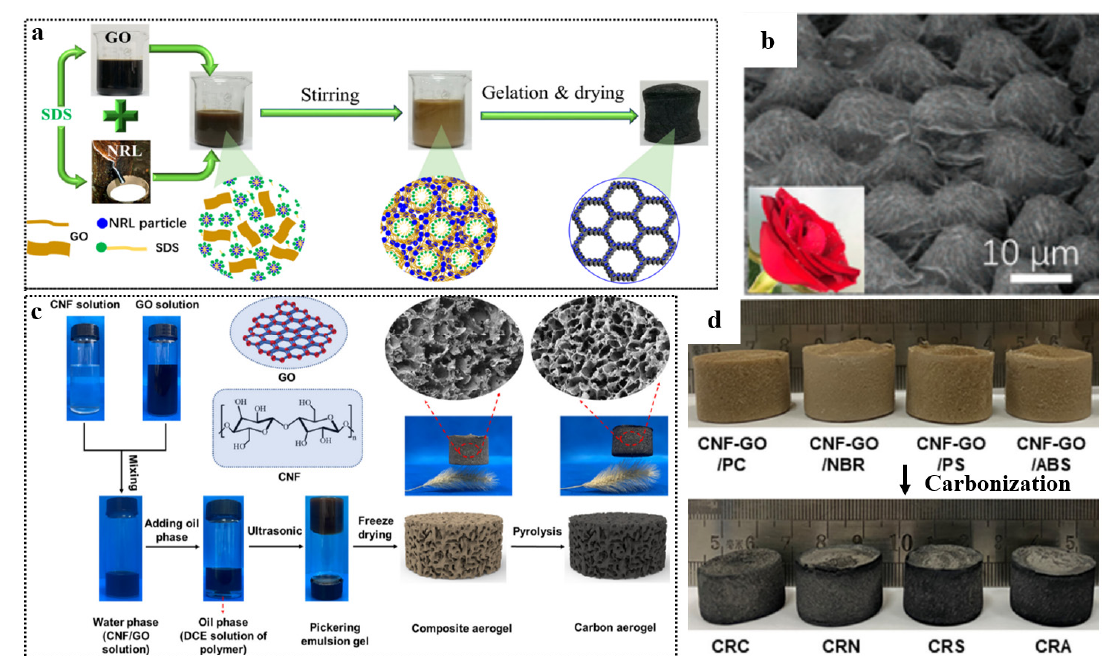
Figure 8. ( a ) Synthesis pathway of GA/NRL and the corresponding inner structure evolution. ( b ) Pictures of a rose petal and the surface morphology of GA/NRL. Reproduced with permission from [23]. ( c ) Schematic illustration of the preparation process of carbon aerogel. ( d ) Digital photos of the composite aerogel. Reproduced with permission from [80].